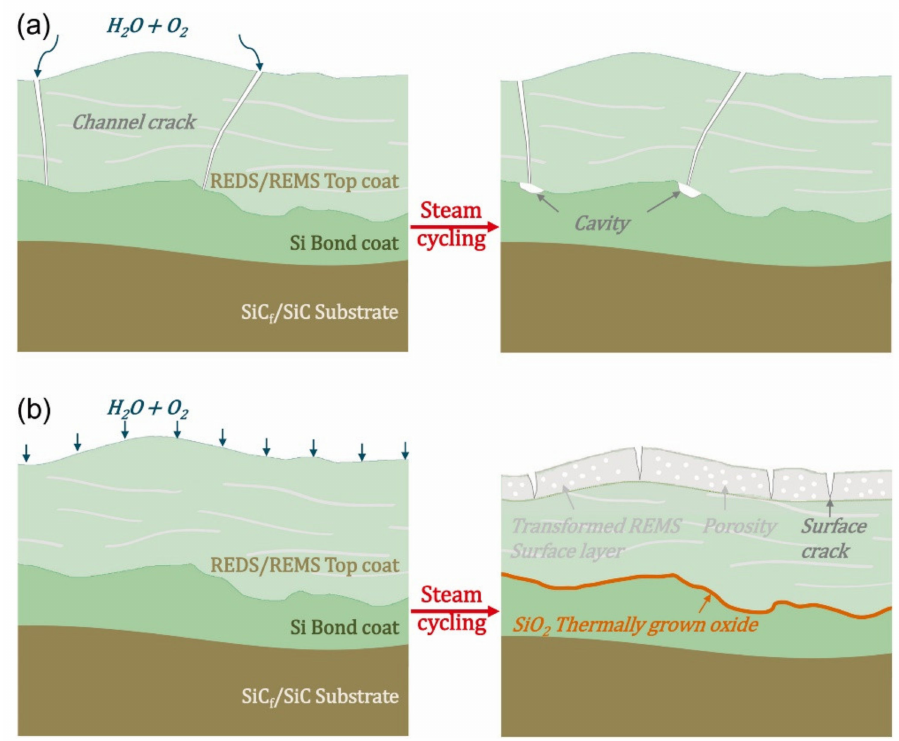
Figure 9. ( a ) Premature failure via interface delamination through channel cracks; ( b ) intrinsic failure via coating spallation at topcoat surface